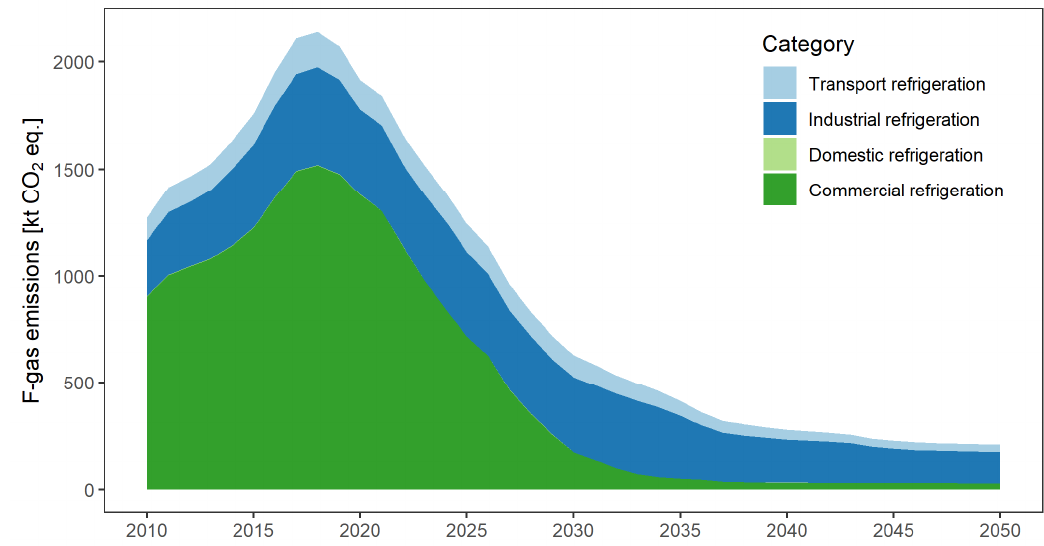
Figure 4. Forecast of F-gas emissions from refrigeration.